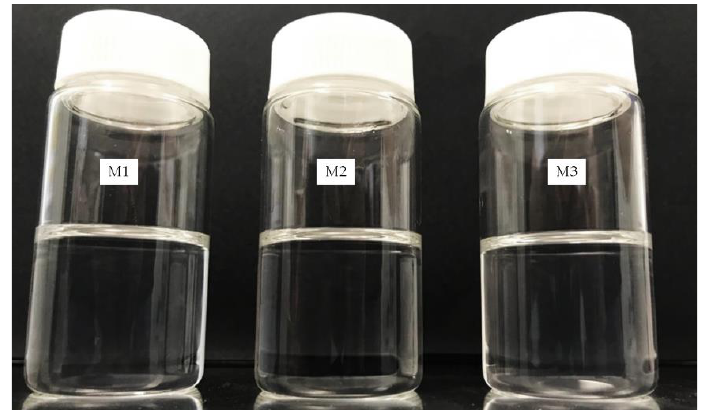
Figure 3. Appearance of loaded microemulsions M1, M2 and M3.